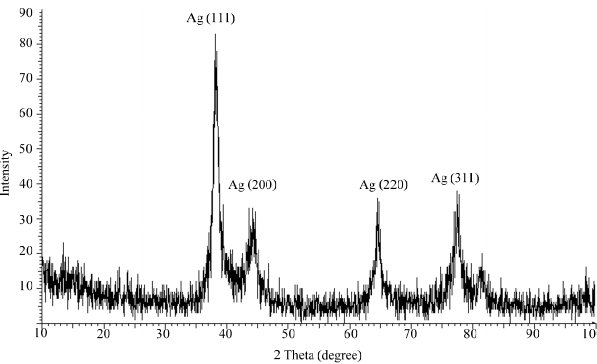
Fig. 4. FT-IR Spectrum of A) L. officinale root aqueous extract and B) biosynthesized silver